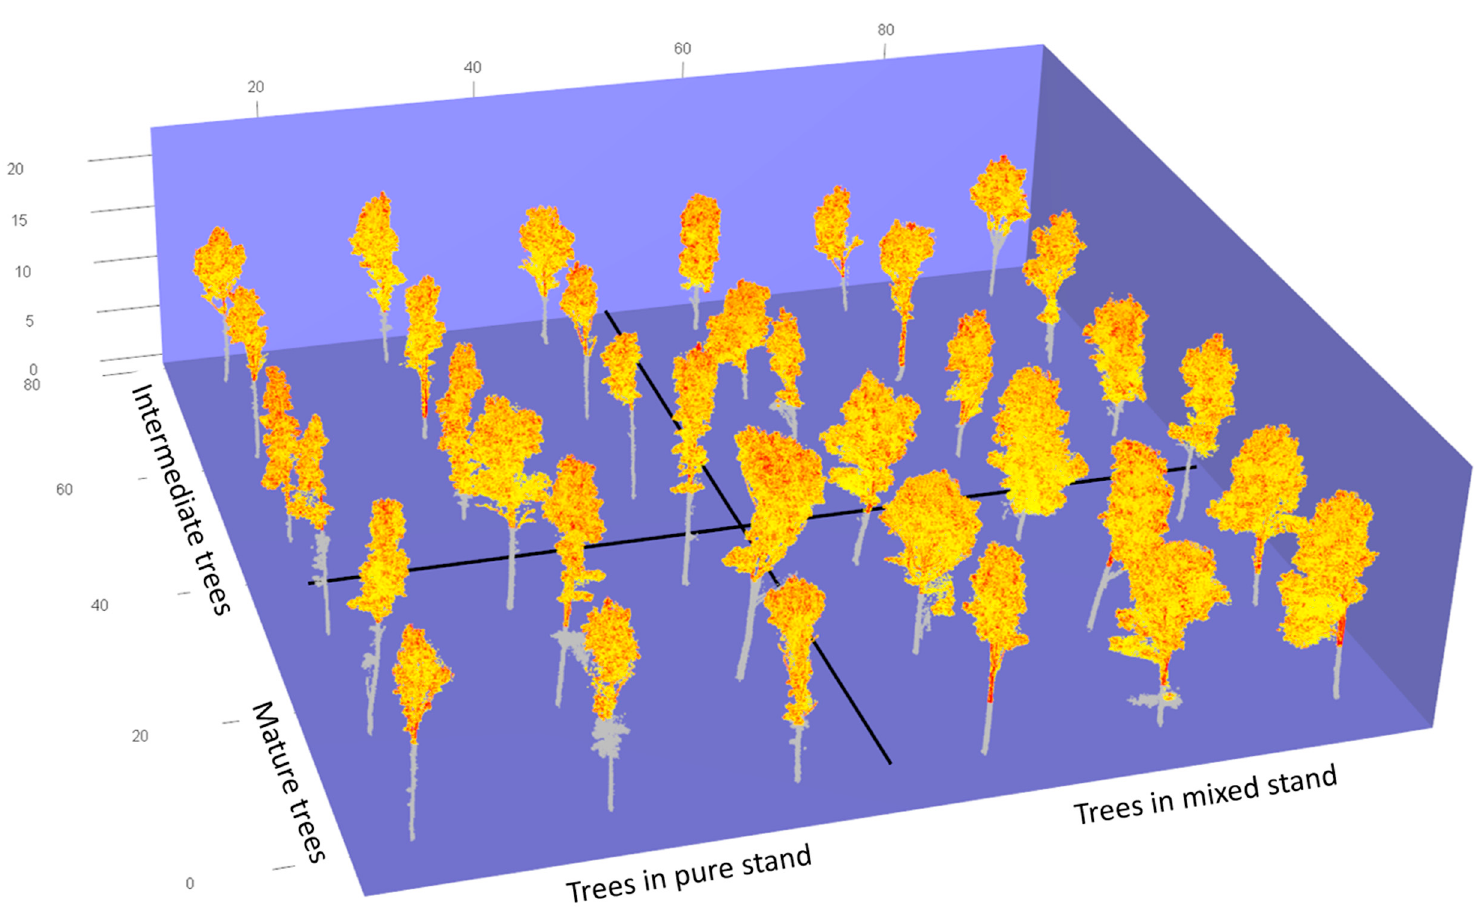
Figure A2. Three dimensional representation of all sugar maple trees (72 trees). The voxels of the crowns are represented with a color gradient from yellow to red for RDIT values (similar to Figure 2).